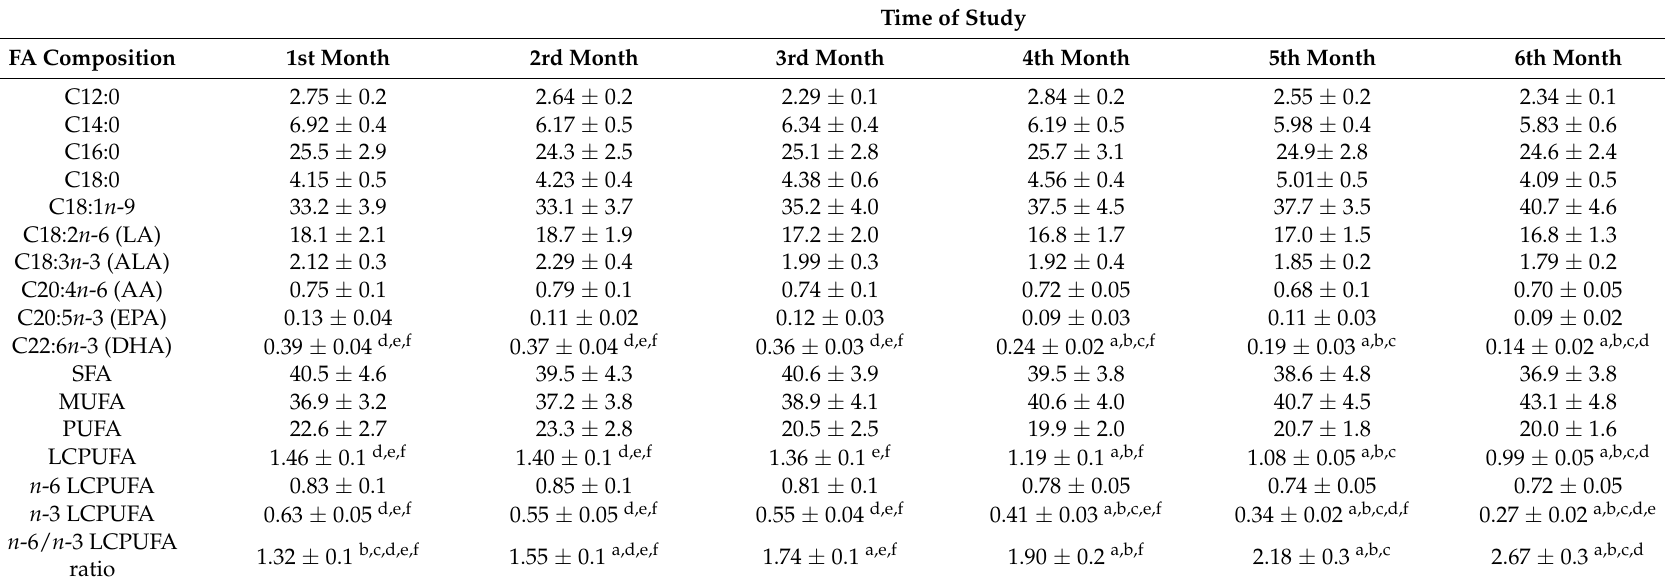
Table 6. Composition of most relevant fatty acid from breast milk of the women during the lactation period studied. Time of